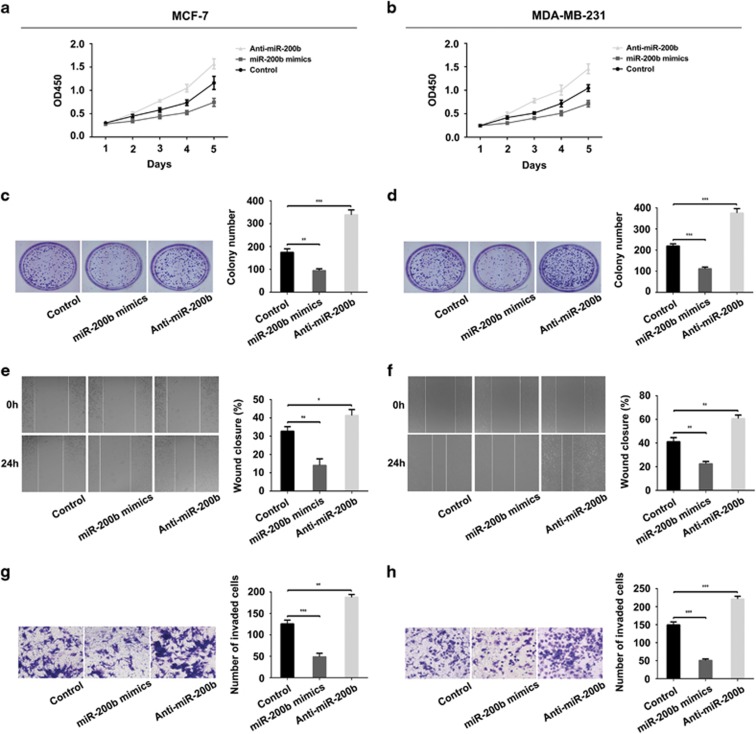
miR-200b inhibits the proliferation, migration and invasion of MCF-7 and MDA-MB-231 cells. (a, b) CCK-8 assay was applied to detect the ability of cell growth. Cells plated with a density of 3000 cells per well were transfected with miR-200b mimics and Anti-miR-200b, respectively. Absorption at 450 nm was detected for 5 consecutive days. (c, d) Colony-formation assay. Cells were plated with a density of 1000 cells per well after transfected with miR-200b mimics and Anti-miR-200b. Images were taken after surviving colonies were stained with crystal violet. The number of colonies was counted. Representative images and statistical analysis were shown. (e, f) Wound-healing assay. Cells were transfected with miR-200b mimics and Anti-miR-200b for 48 h and scratched with a 200 μl pipette tips. Then cells were cultured for another 24 h. The migratory ability of the cells was detected at the indicated times (0 and 24 h). Representative images and statistical analysis are shown. (g, h) Transwell assay. Cells (1 × 105) were transfected with miR-200b mimics and Anti-miR-200b, respectively. Cells were added onto the upper chamber of the inserts followed by 24 h incubation. Invasion ability of the cells was determined after crystal violet stain. Ten fields in each group were recorded and counted per filter. *P<0.05, **P<0.01, ***P<0.001.